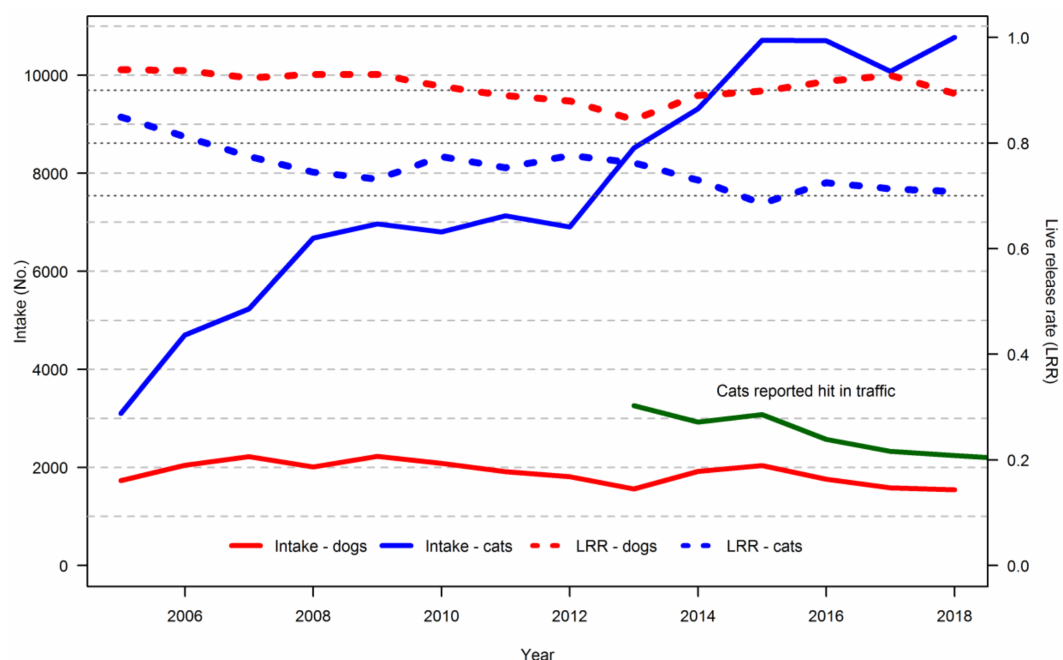
Figure 1. Intake numbers (full red and blue lines) and live release rates (dotted lines) for cats and dogs, summarised for 37 shelters in Denmark. Annual summarised records of cats hit by vehicles from one of the major organisations were also obtained (green line).